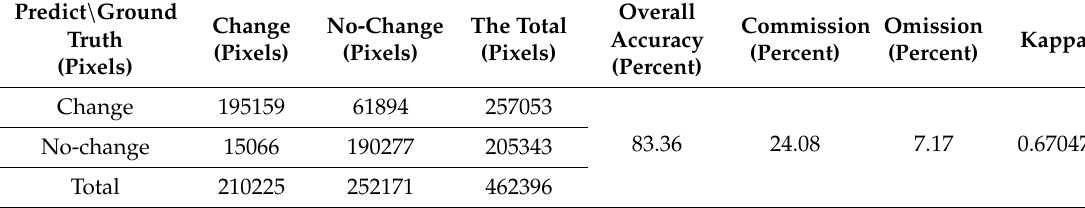
Table 2. Result statistics for testing expanded area.